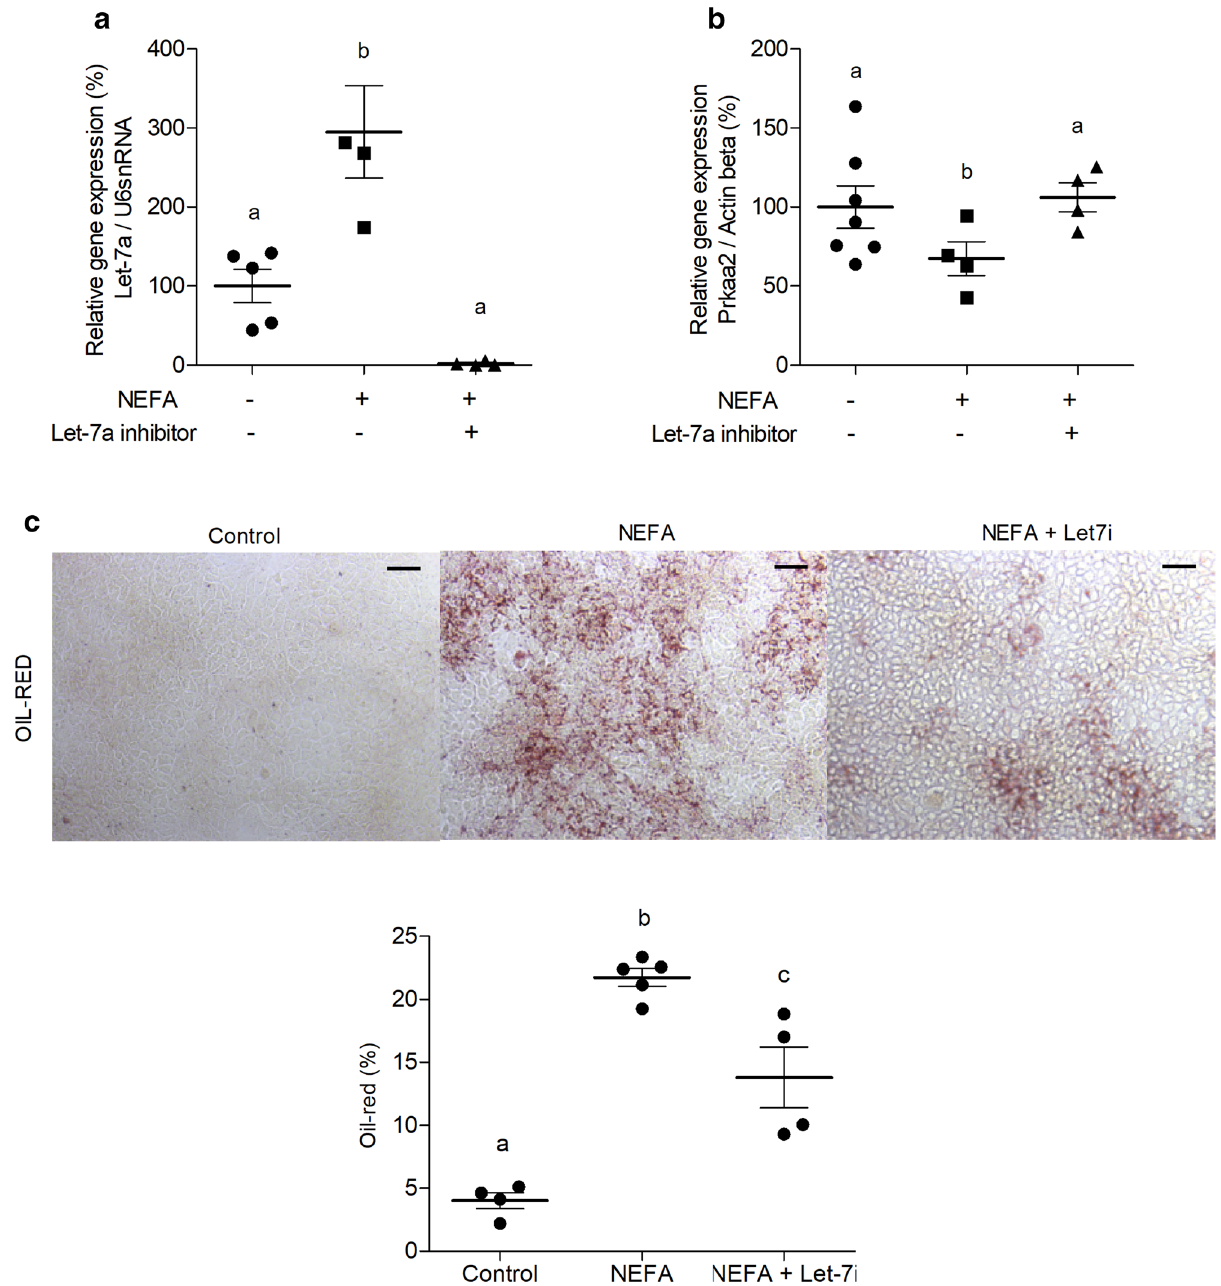
Figure 3. Inhibition of Let-7a rescues NEFA-induced alterations in hepatocytes. qRT-PCR of Let-7 a (a) and Prkaa2 (b) ; representative Oil-red images (scale-bar = 10 µm), and quantification (c) of AML12 cell extract treated with NEFA (500 μM) or NEFA (500 μM) plus Let-7 a inhibitor transfection (10 nM) for 24 h. Experiments were performed in quadruplicates and repeated twice. One-way ANOVA were used in the qRT-PCR analysis to compare all groups. Bonferroni post-hoc test was used to determine a significance level of p ≤ 0.05. Values are means with their standard errors represented by vertical bars. Different letters indicate statistical significance between